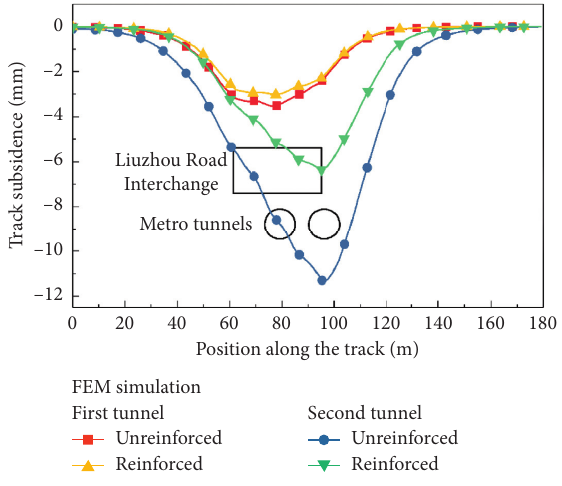
Figure 6: FEM simulation results.